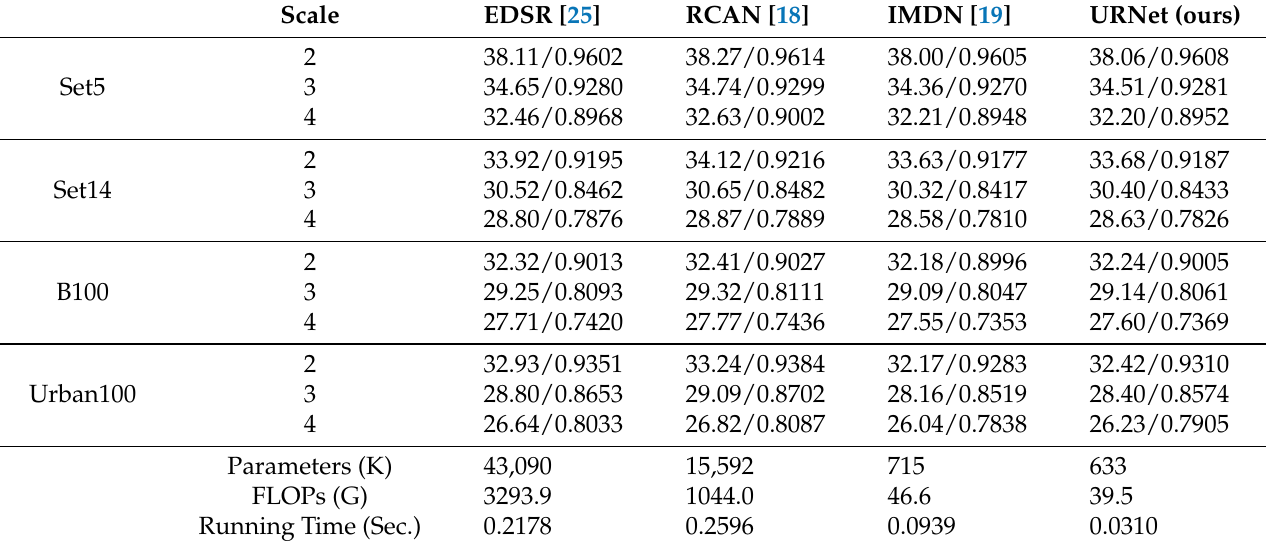
Table 6. Comparison with non-lightweight and SOTA lightweight